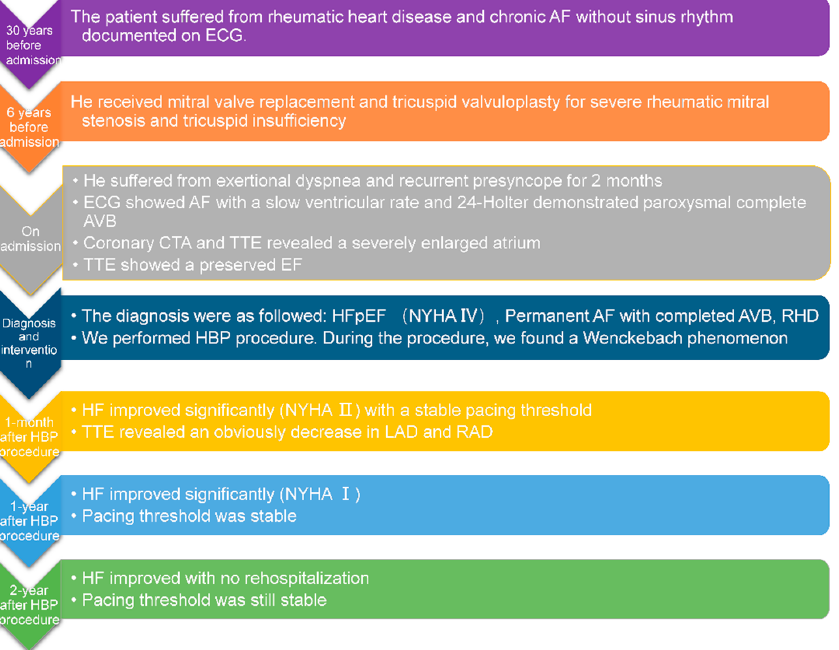
Figure 4. Timeline showing the clinical course in this